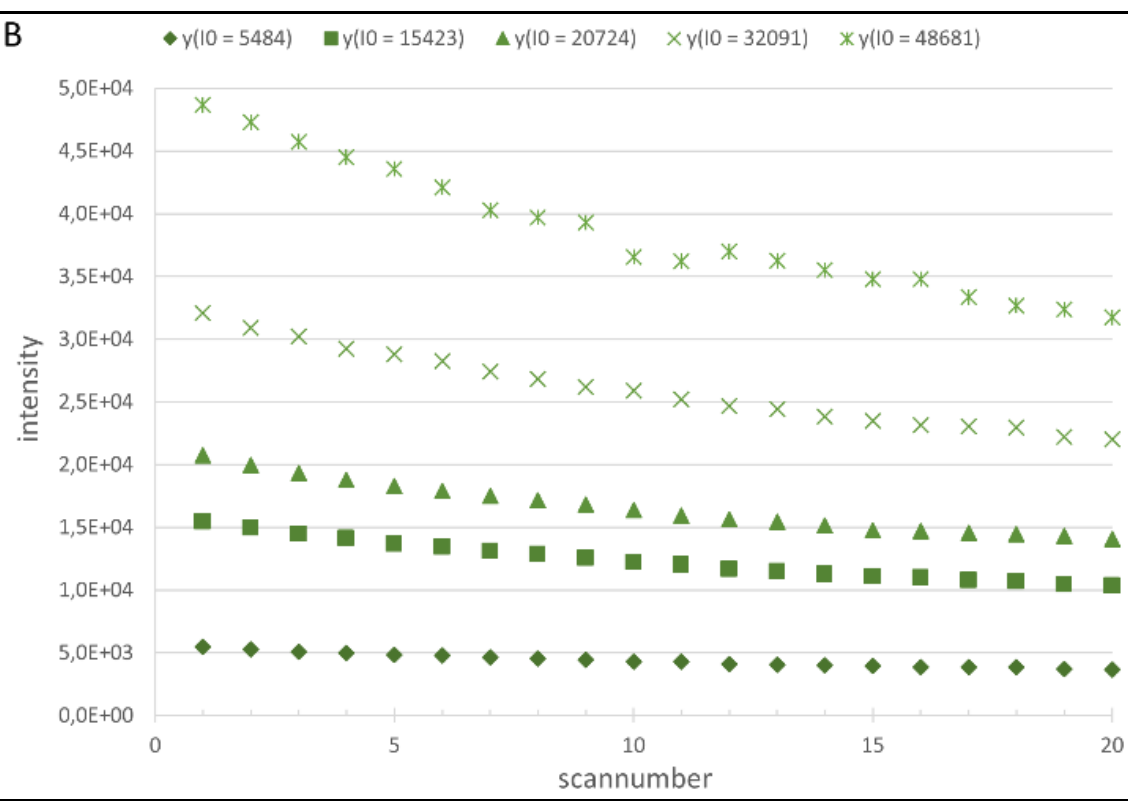
Figure 1. ( A ) Change in measured intensity of Cy5-labeled cDNA spots with increasing number of scans, depending on their initial intensity; and ( B ) change in measured intensity of Cy3-labeled cDNA spots with increasing number of scans, depending on their initial